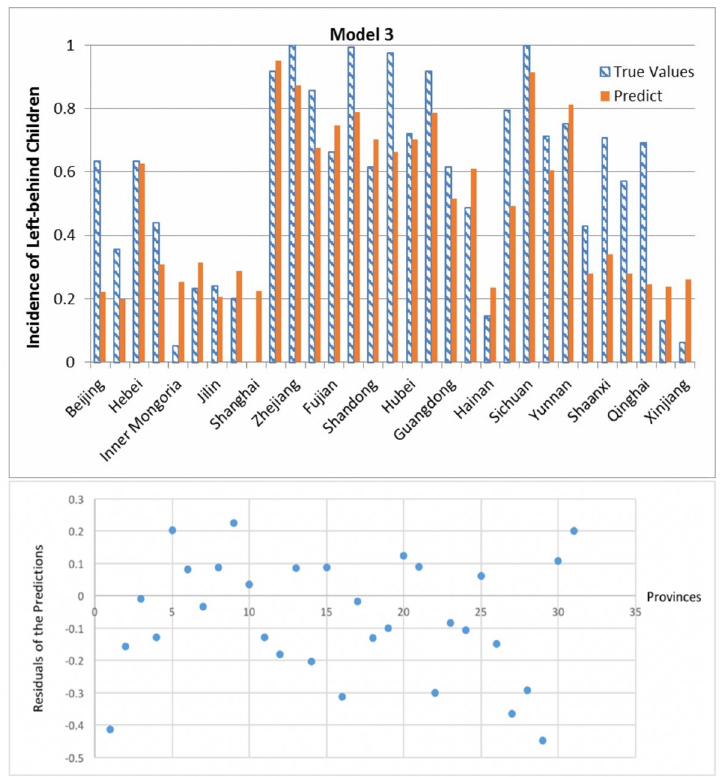
Fig 11. Prediction results and residuals of Model